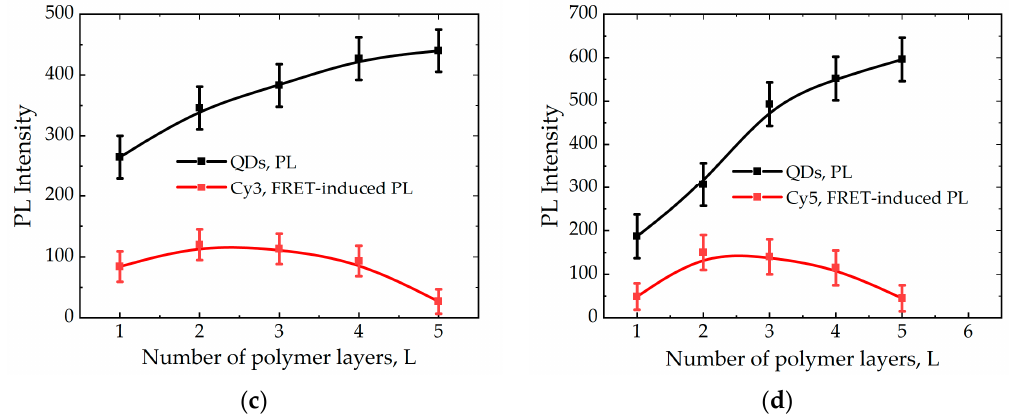
Figure 4. ( a ) Photoluminescence (PL) spectra of PMS-AIS, PMS-AIS-Cy3 L2 and deconvolution of PMS-AIS-Cy3 L2 by AIS and Cy3 PL band. ( c ) Dependence of QD PL and Cy3 FRET-induced PL on number of polymer layers L. ( b ) PL spectra of PMS-AIS, PMS-AIS-Cy5 L2 and deconvolution of PMS-AIS-Cy5 L2 by AIS and Cy5 PL band. ( d ) Dependence of QD PL and Cy5 FRET-induced PL on number of polymer layers L.